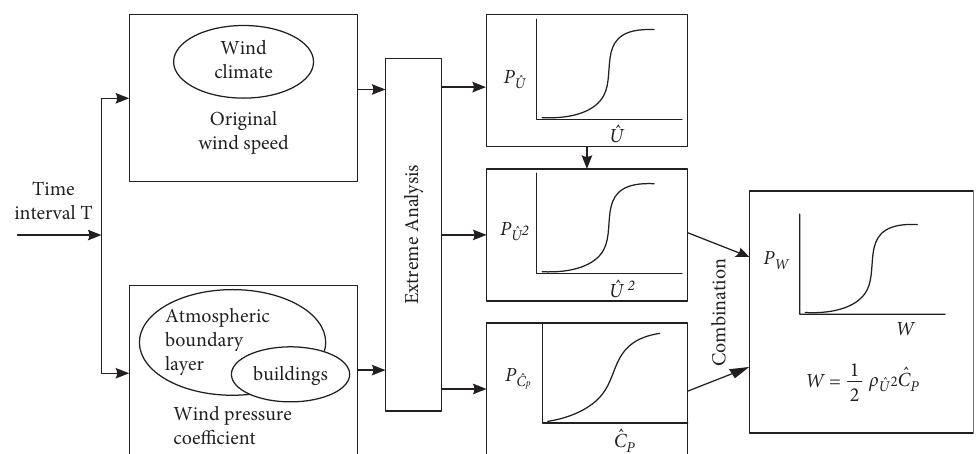
Figure 1: Modeling diagram for calculating wind load.